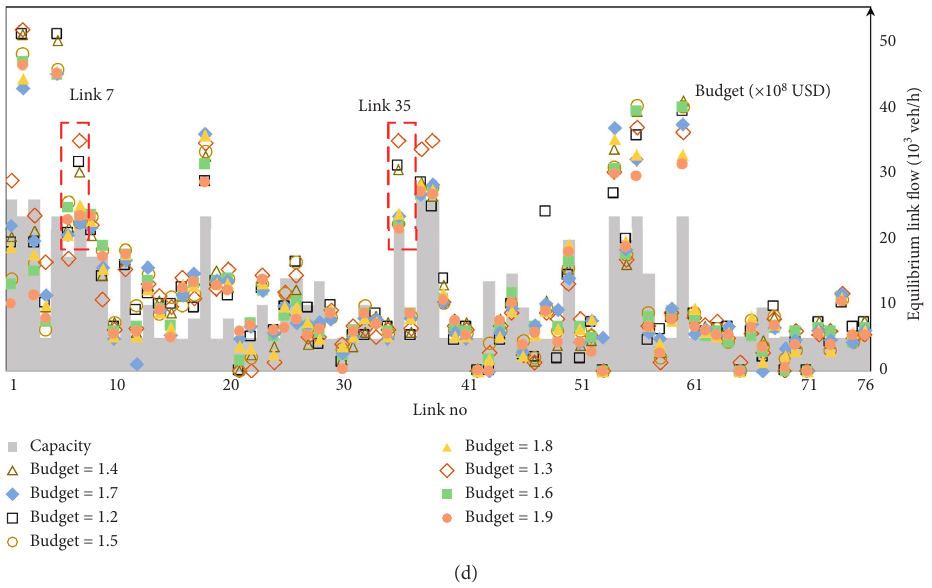
Figure 3: Comparison under different budget limits. (a) Comparison of location designs under different budgets. (b) Total travel time and ER cost. (c) The number of ERs under different budgets. (d) Equilibrium flow of different location designs under different budgets.